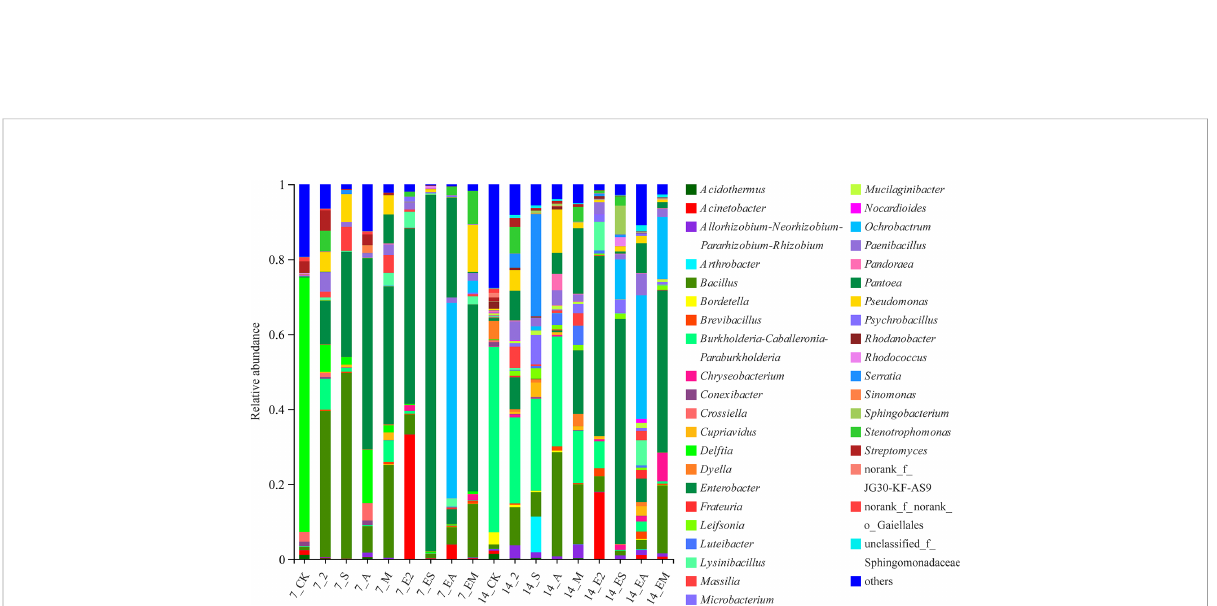
FIGURE 7 Relative abundance of bacterial genera following chemoattractant and chemoattractant-plus-chemotactic strain treatments at 7 and 14 days.